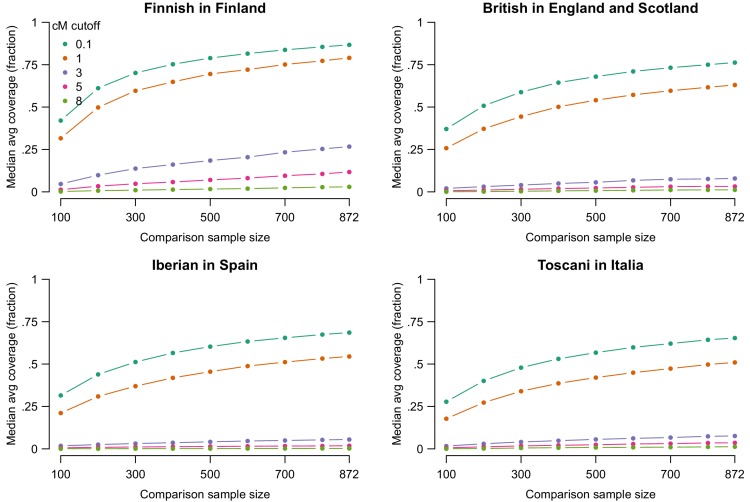
IBS tiling performance in selected populations.We examined IBS tiling performance in four European populations from the 1000Genomes data—Finnish in Finland (FIN, top left, 99 people), British in England and Scotland (GBR, top right, 91 people), Iberian in Spain (IBS, bottom left, 107 people), and Toscani in Italia (TSI, bottom left, 107 people). In all panels, median average IBS tiling coverage is shown on the vertical axis using refinedIBD with LOD>1, as in the top-left panel of Figure 2. Median tiling accuracy varies among populations. For example, using IBS tiles >1 cM and with all 871 other individuals used in the comparison sample, the median coverage percentages by population were 79% (FIN), 63% (GBR), 55% (IBS), and 51% (TSI). The most striking population difference is the higher IBS tiling rates attained among Finns, who have long been of interest as a founder population, having experienced a bottleneck approximately 100 generations ago (Kere, 2001). Another factor that likely influences these results is the genetic similarity of members of each population to members of other populations included—for example, the CEU population of 1000Genomes is closely related to the GBR population, and the inclusion of CEU may partially account for the higher tiling rates in GBR than in IBS or TSI.Figure 2—figure supplement 4—source data 1.IBS tiling performance in selected populations.